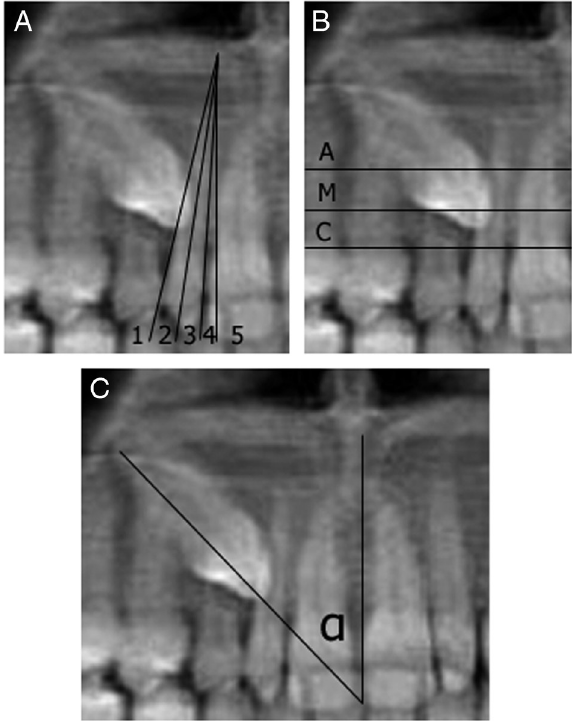
Figure 3. Location of impacted canine: (A) Canine overlap of incisor sectors 1–5, (B) Height of the canine and area of resorption, (C) Angulation of canine to the vertical midline between the central incisors.